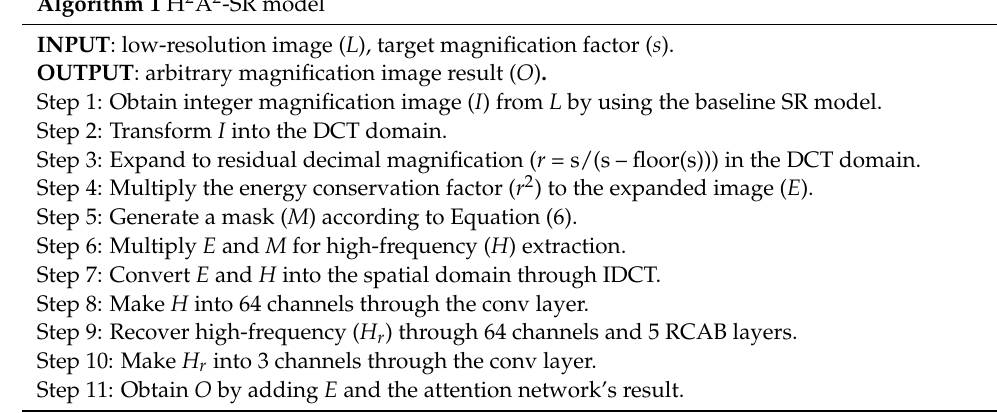
Algorithm 1 H 2 A 2 -SR